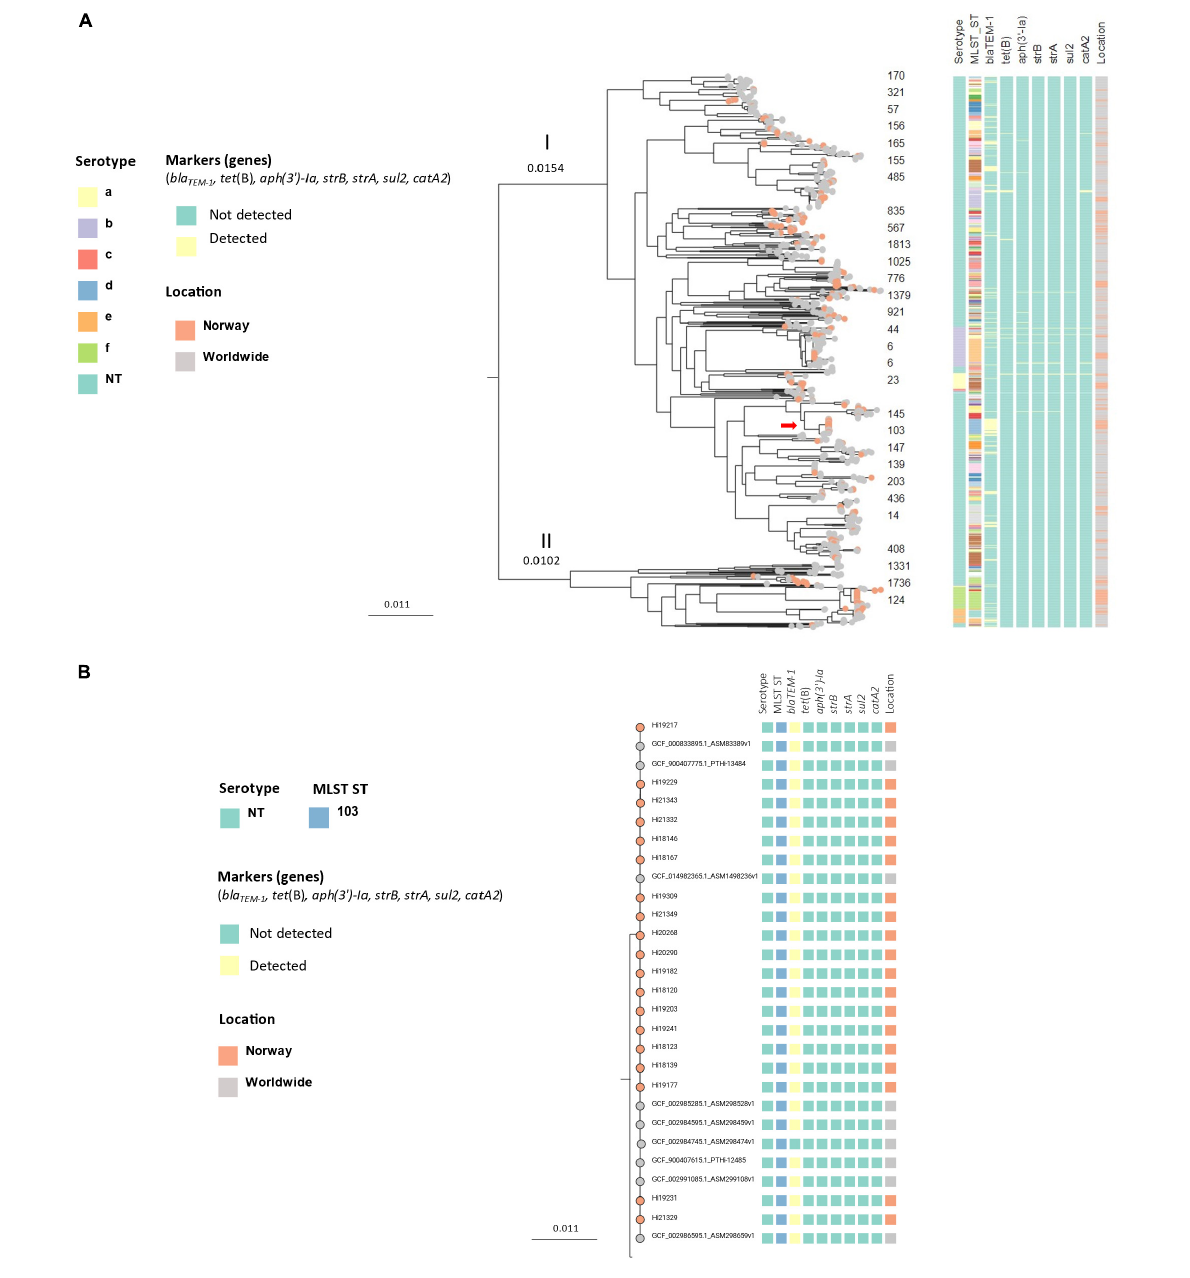
FIGURE5 (A) Midpoint-rooted approximately-maximum-likelihood phylogenetic tree based on core genomes (core genes: 840) of 245 invasive Haemophilus influenzae isolates from Norway 2017–2021 (colored leaf nodes) and 797 publicly available sequences worldwide, annotated with serotypes, STs and transferable resistance genes. The red arrow shows the bla TEM − 1 -carrying ST103 NTHi clone. (B) Detailed presentation of the bla TEM − 1 -carrying ST103 NTHi clone [red arrow in panel (A)